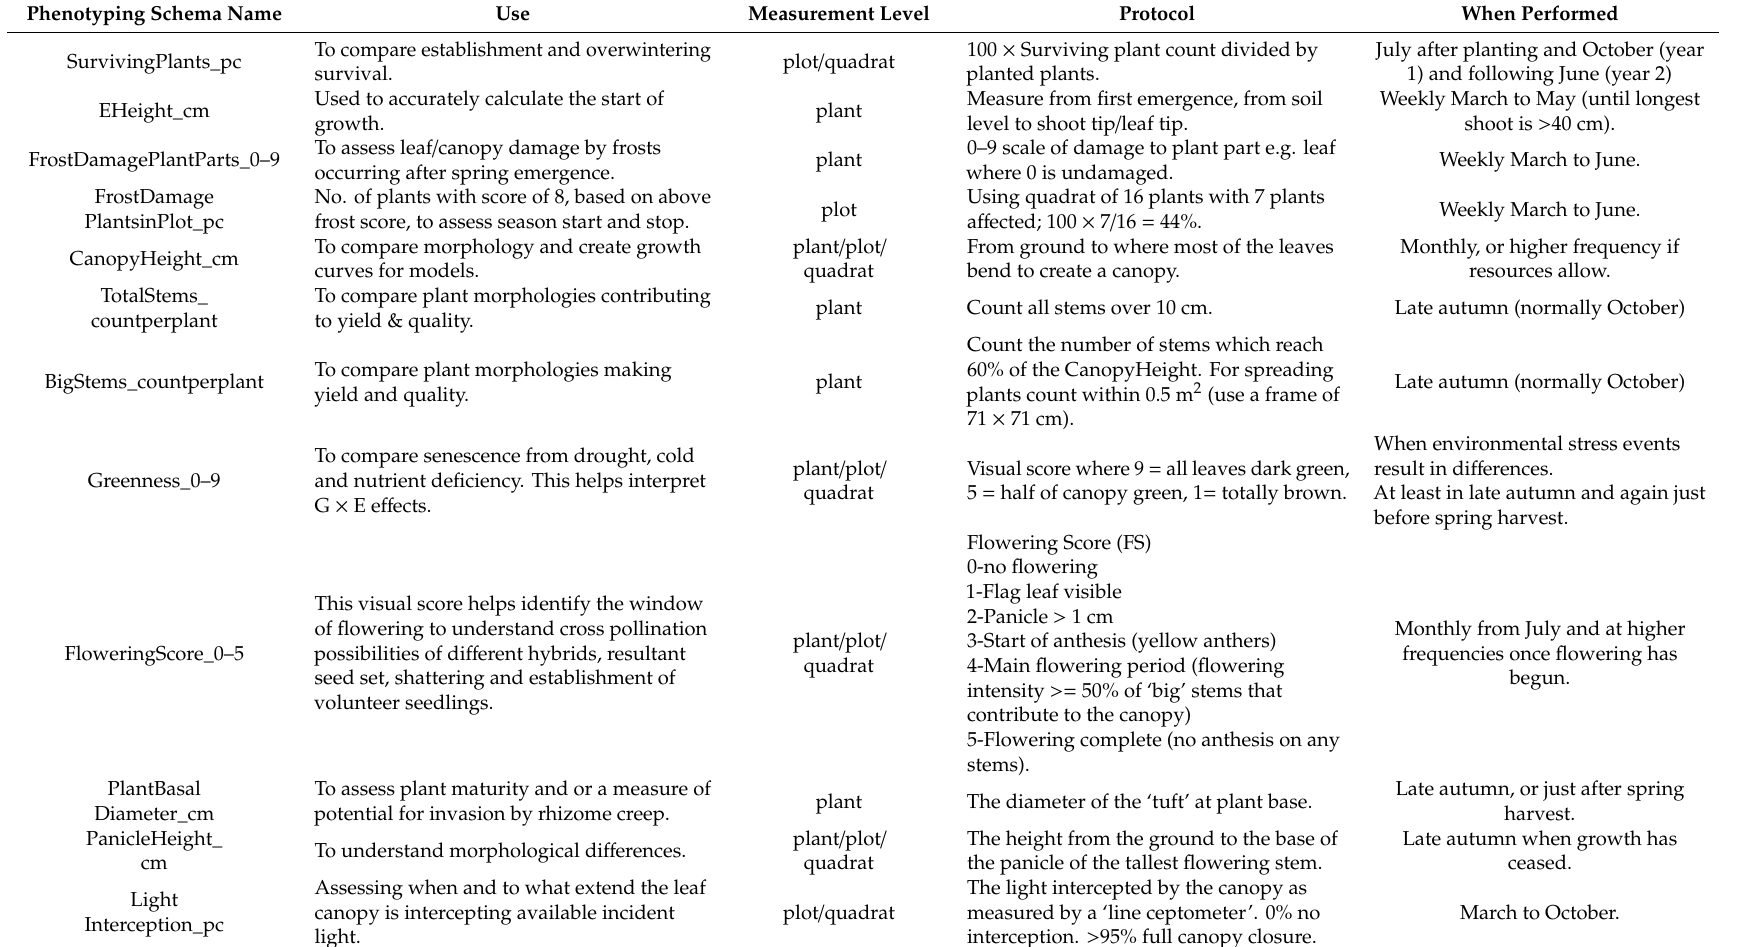
Table 1. Phenotyping schema names and protocols developed for